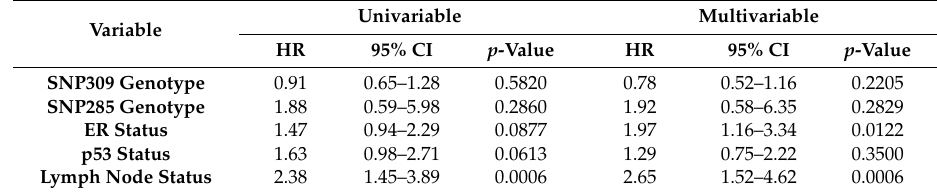
Table 5. Univariable and multivariable analyses of the disease-free survival using a Cox proportional hazards model.